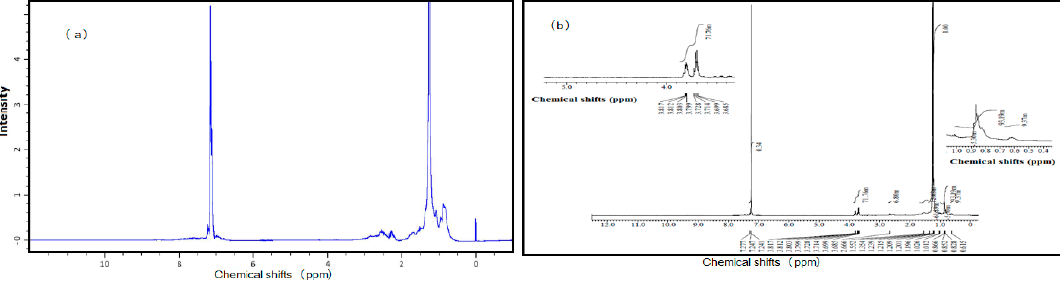
Figure 2. 1 H NMR spectra of a ) asphaltenes and b ) ASAS.